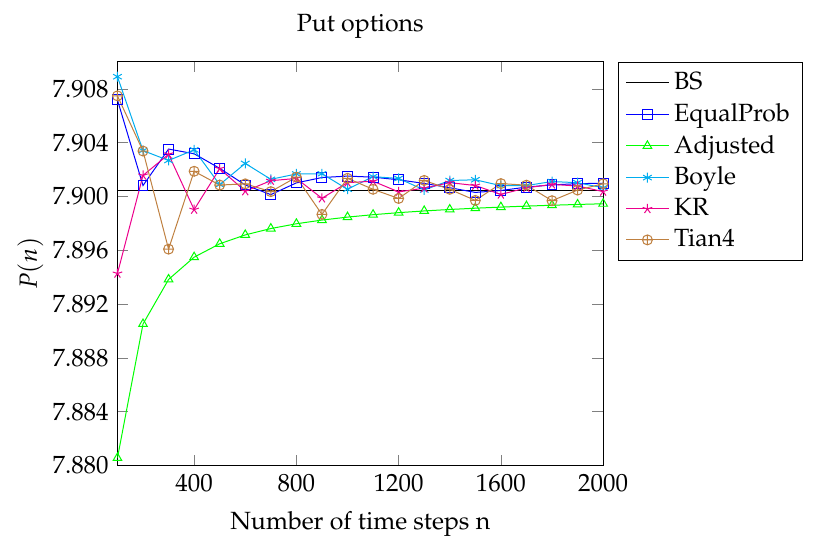
Figure 1. Here, S = 100, K = 105, r = 0.05, σ = 0.2 and T = 1. We plot the prices P ( n ) of put options in various trinomial models against the Black–Scholes price P BS = 7.900442.